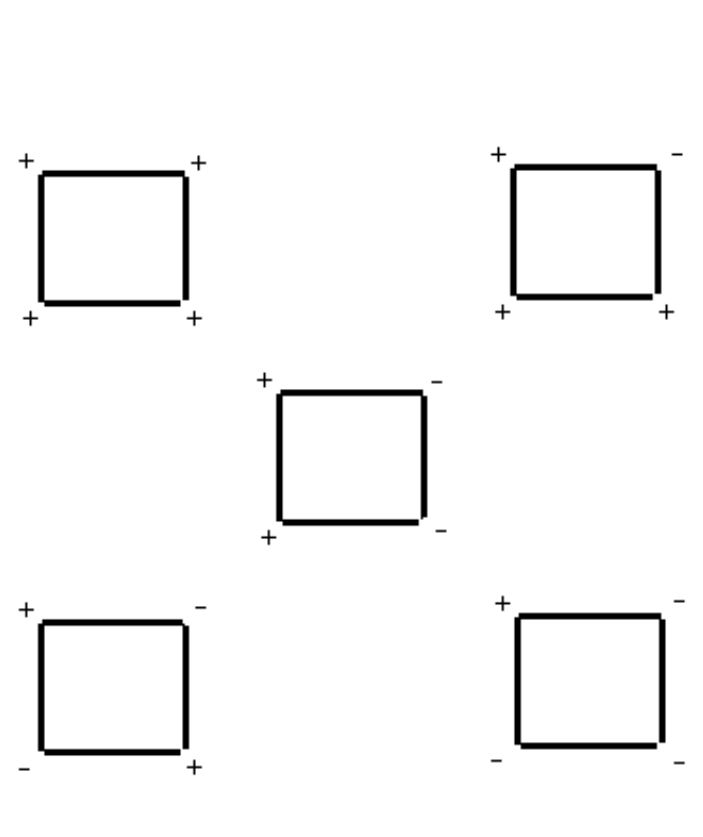
Figure 3. Conformers of MnT(2-C)PP. "+" reflects a carboxy group above the plane of the porphyrin ring. "-" reflects one below the ring. The Mn(III) ion lies slightly above the plane of the